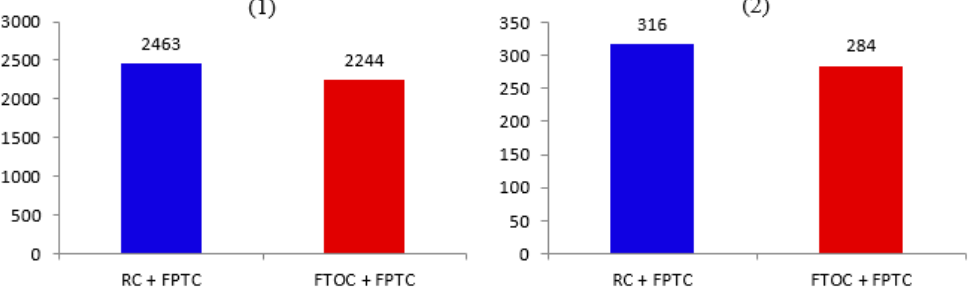
Figure 15. Comparison results of the RC + FPTC vs. the FTOC + FPTC: ( 1 ) total fuel consumption (g), ( 2 ) total NO x emission